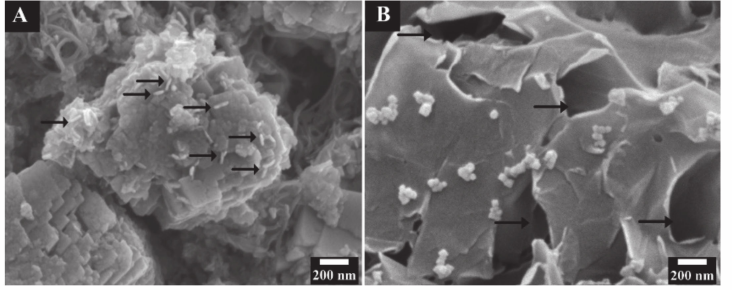
Figure 9. SEM images of the Mn 3 O 4 -MWCNT electrodes: ( A ) as prepared, arrows show MWCNT in the Mn 3 O 4 matrix, ( B ) after cycling, arrows show large